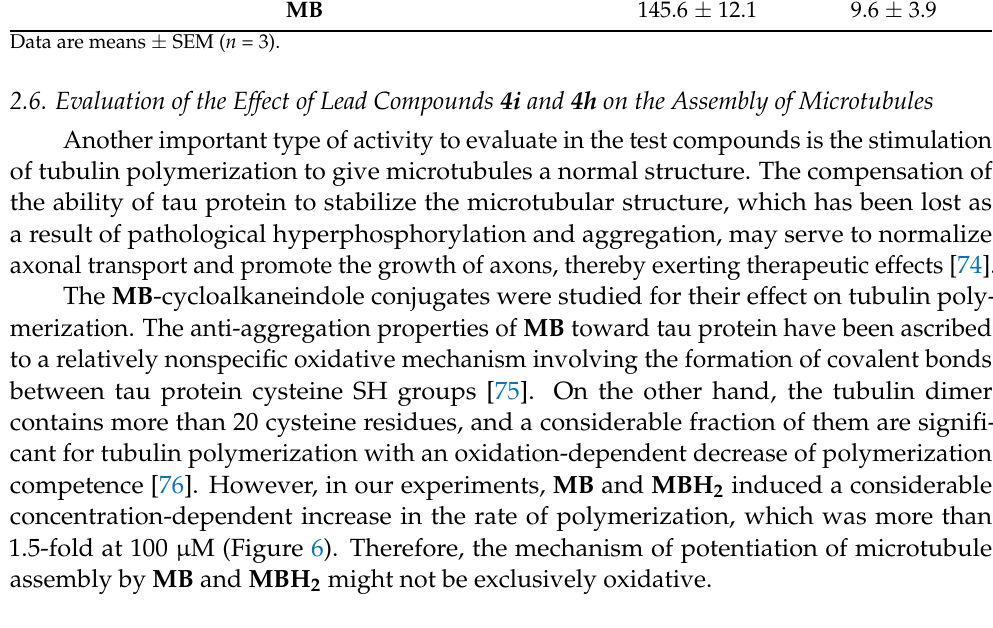
Table 5. Effect of the MB –cycloalkaneindole conjugates on the binding of [ 3 H]MK-801 and [ 3 H]ifenprodil ligands to different sites of the NMDA receptor. Compounds IC 50 ( µ M) R R 1 [ 3 H]MK-801 4h